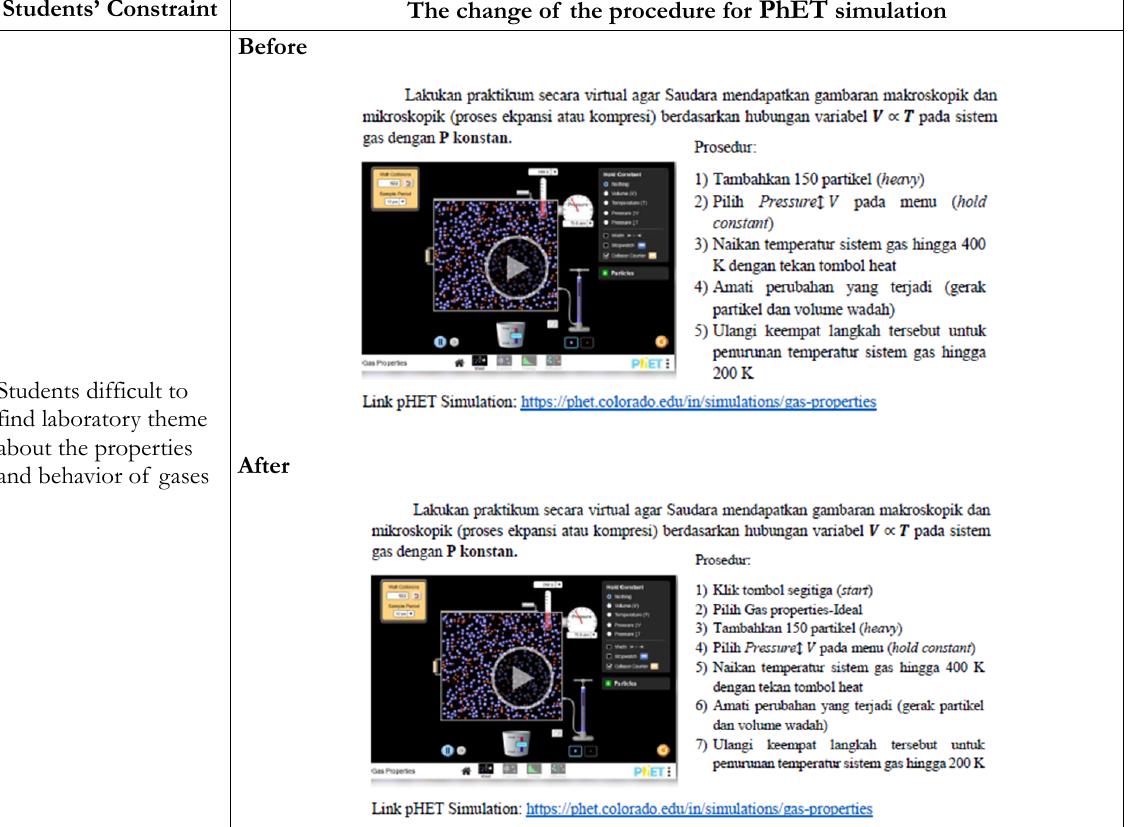
Table 7. The readability result